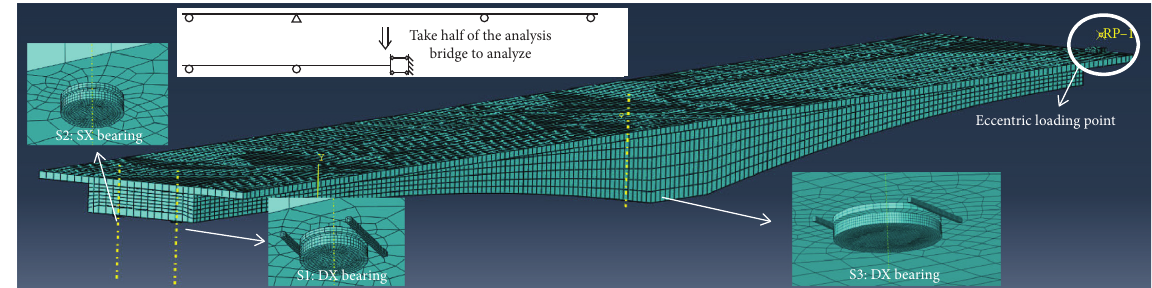
Figure 6: The solid model (half model) and mesh of the analysis